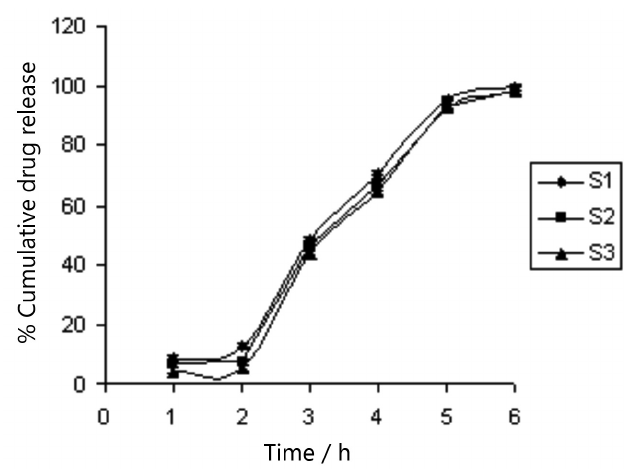
FIGURE 4 - Comparative results of in vitro release profile of hydroxypropyl methylcellulose (HPMC) with sodium alginate (SA)-based diclofenac beads.